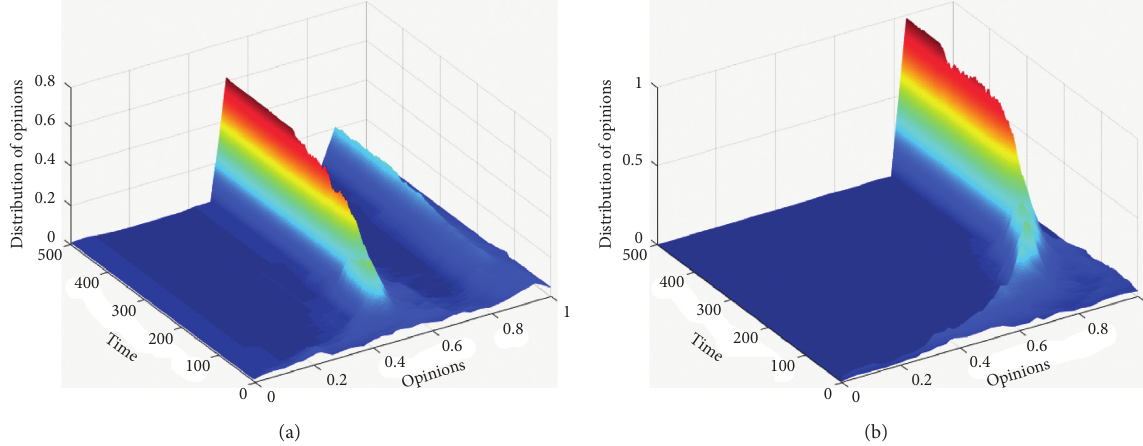
Figure 10: Two opinion leaders with positive opinion values. There are two opinion clusters when d opinion cluster with the larger agent proportion is close to 0.5, while the other is close to 0.8; there is only one opinion cluster when d m � 0 . 9, the opinion value of the opinion cluster is close to 0.8. (a) d m � 0 . 45. (b) d m � 0 . 9.